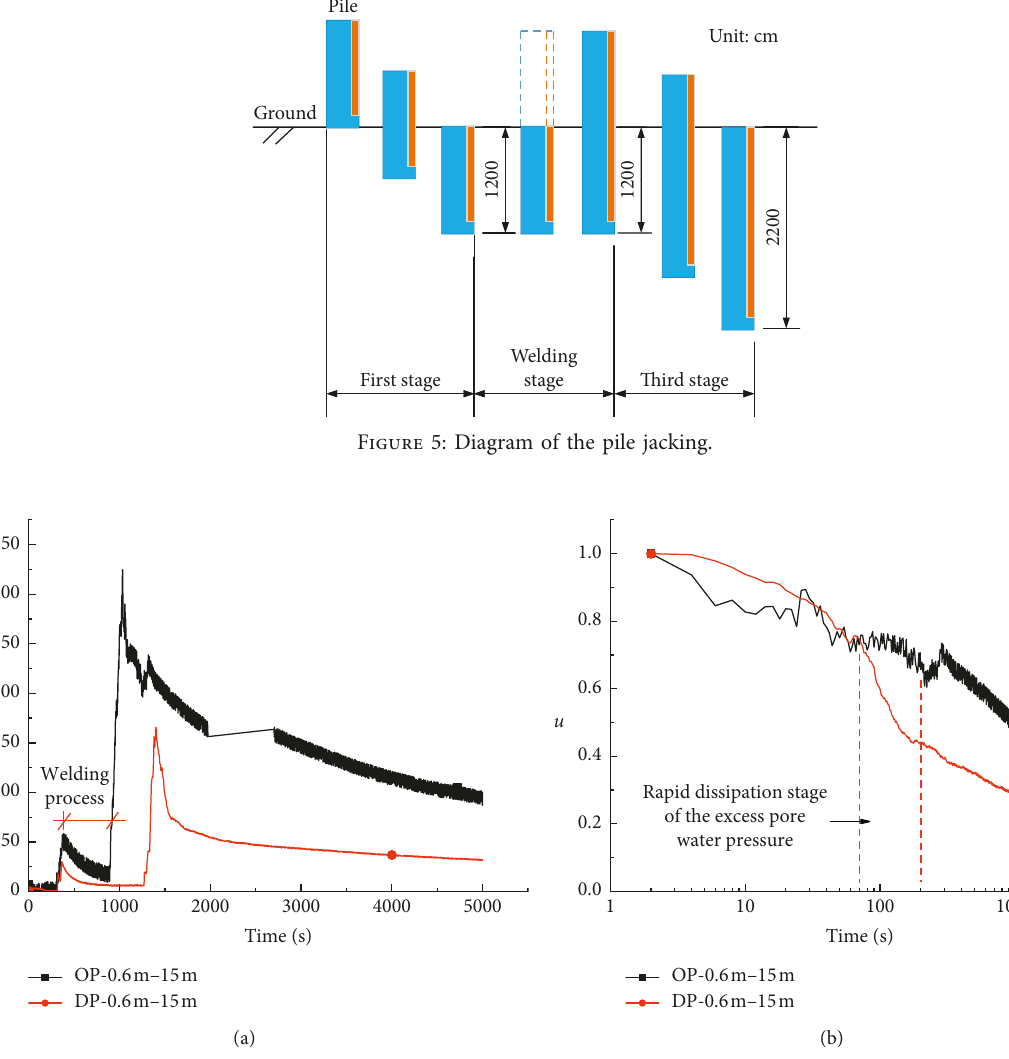
Figure 6: Time histories of the excess pore water pressure at 15m depth. (a) Dissipation curves at measuring point 0.6m from the pile center. (b) Logarithmic dissipation curves at measuring point 0.6m from the pile center.